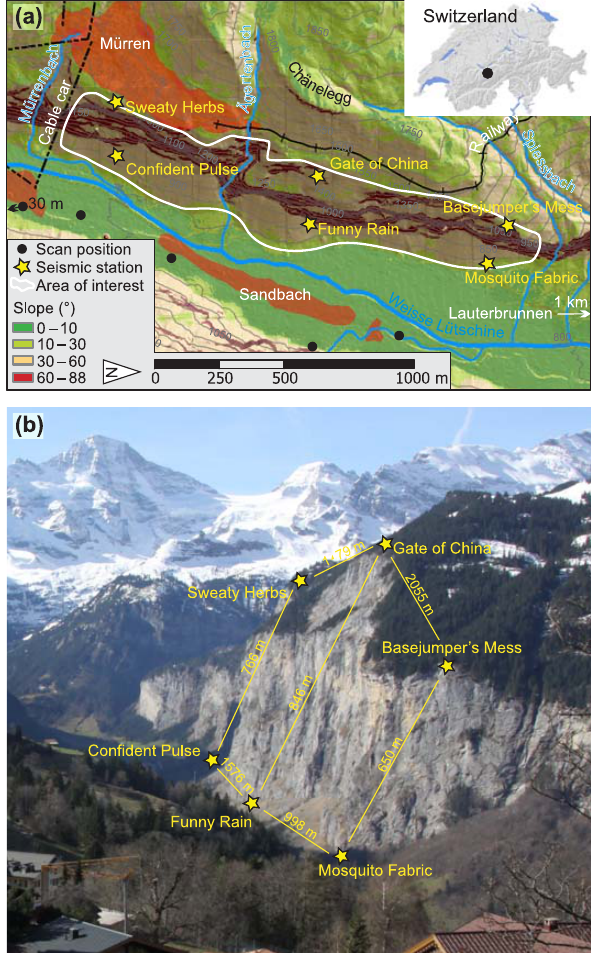
Figure 1. The study area Lauterbrunnen Valley. (a) Schematic map with location of seismic stations, TLS positions and anthropogenic noise sources (settlements, technical infrastructure). (b) Photograph of the instrumented east-facing cliff face of the Lauterbrunnen Val- ley with the Breithorn and Tschingelhorn in the background. Seis- mic stations (yellow stars) are separated by 1200m on average.